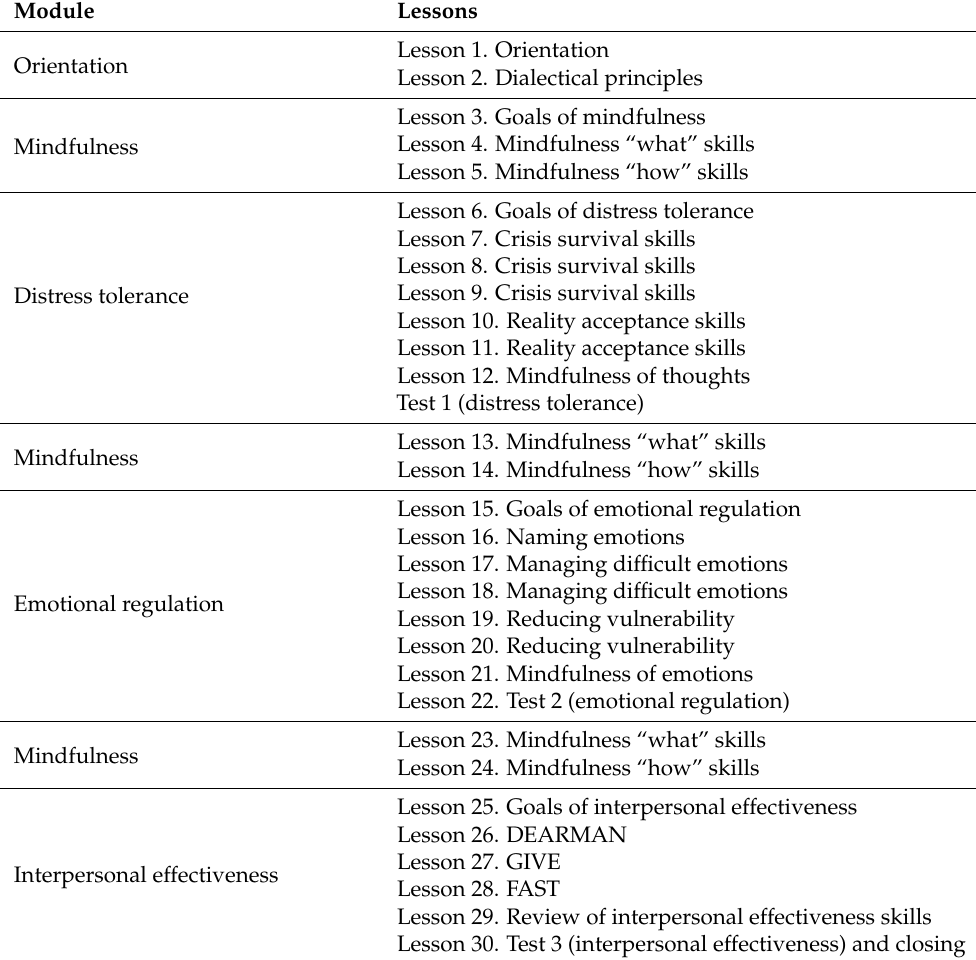
Table 1. Adapted DBT STEPS-A curriculum 1